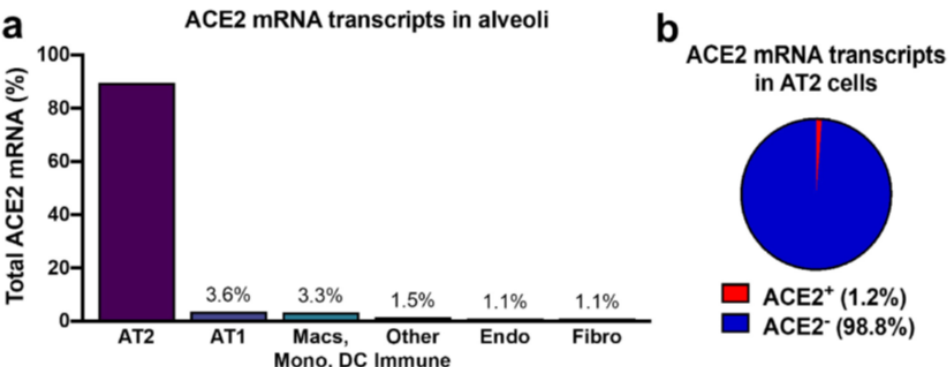
Figure 1. Angiotensin-converting enzyme (ACE)2 expression in human lung. ( a ) Approximately 89.5% of the cells with detectable ACE2 mRNA in the alveoli are alveolar type II cells. ( b ) Only 1–2% of alveolar type II cells have ACE2 mRNA transcripts. Abbreviations: AT2, alveolar type II; AT1, alveolar type I; Macs, Macrophages; Mono, Monocytes; DC, dendritic cells.; Other immune cells,